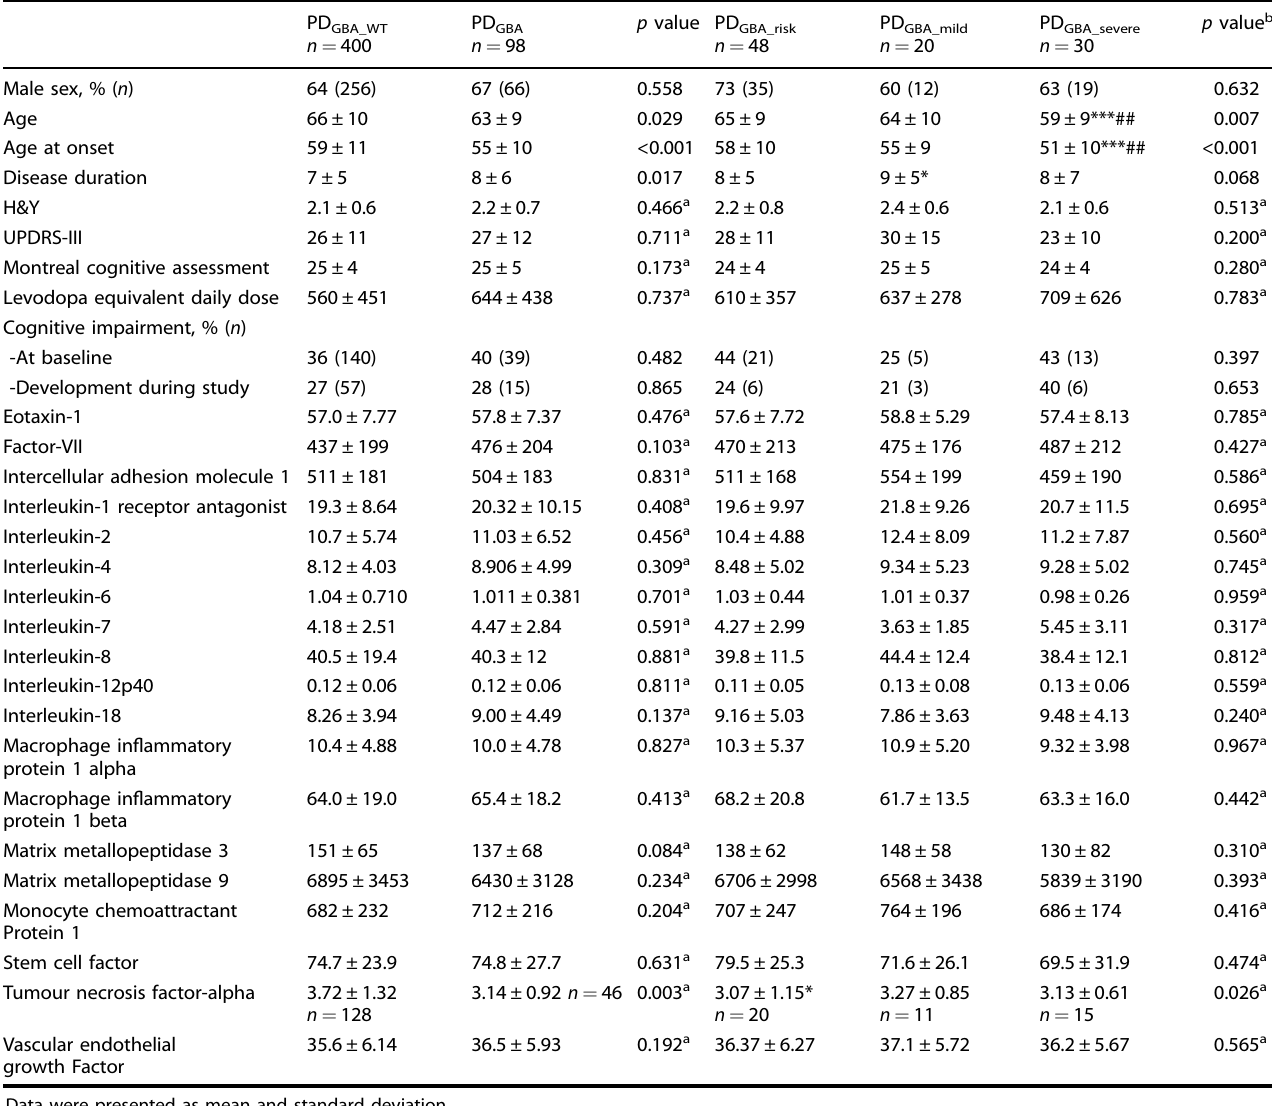
Table 1. Demographic, clinical and CSF in fl ammatory characteristics in people with PD strati fi ed by GBA